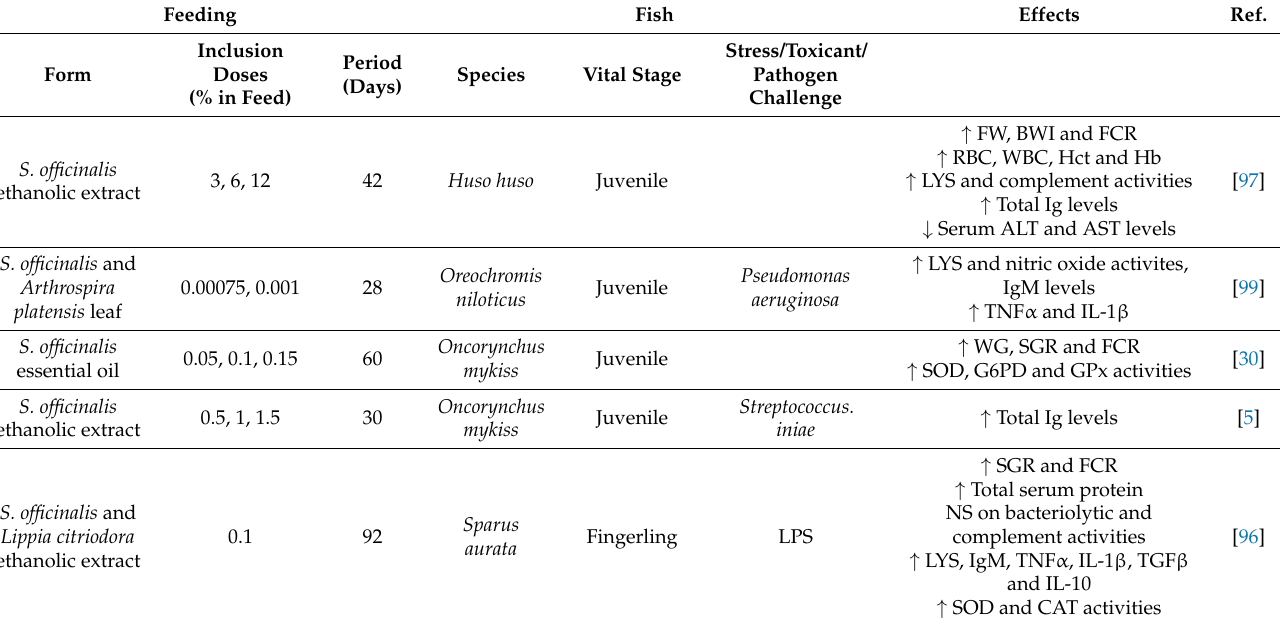
Table 3. Studies of sage products added to the feed of aquaculture